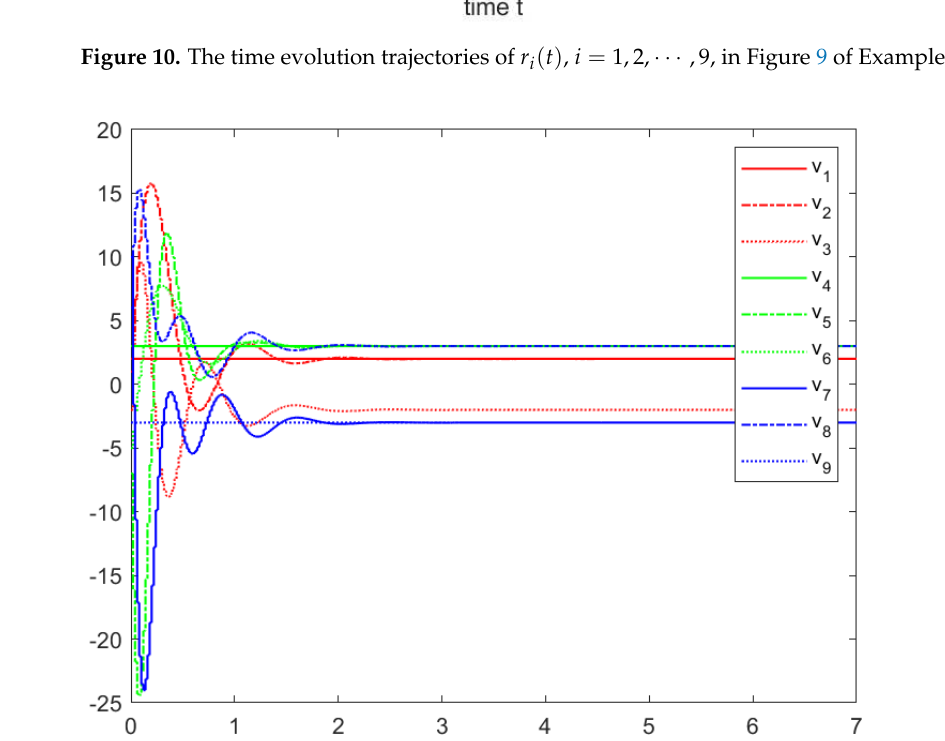
Figure 10. The time evolution trajectories of r i ( t ) , i = 1,2, · · · ,9, in Figure 9 of Example 2.